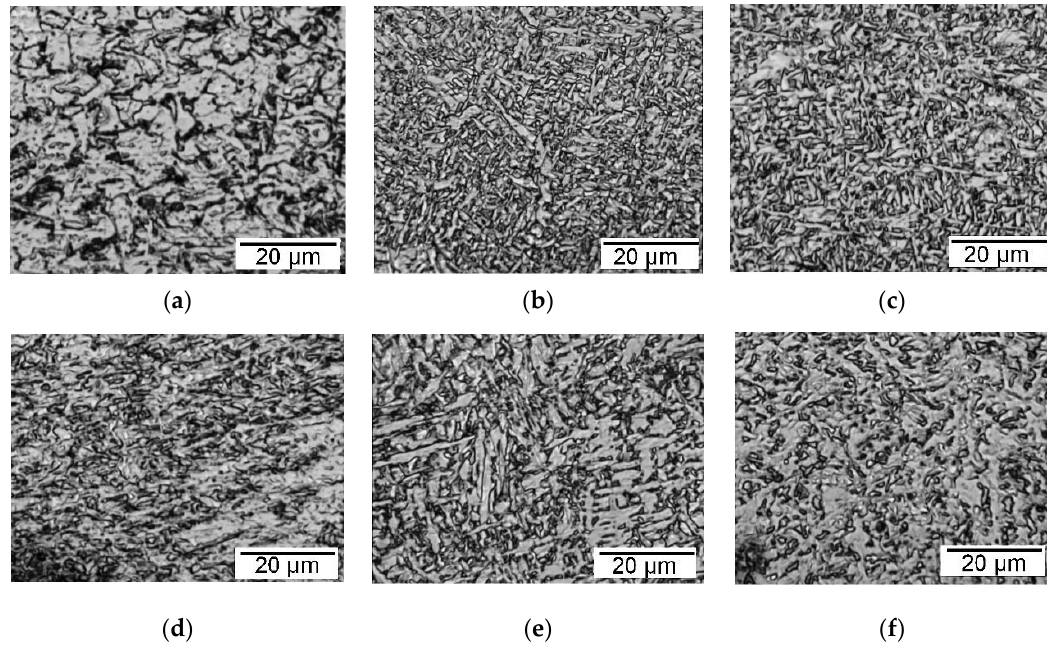
Figure 12. The optical microstructure of the weld metal ( a,b,c ) and of the HAZ ( d,e,f ) in the welding of X70 API steel with G3Si1 wire: ( a,d ) G3Si1 standard wire; ( b,e ) G3Si1 wire with Ni-LaF 3 coating; ( c,f ) G3Si1 wire with Ni-LaB 6 coating of 6 μm in thickness.